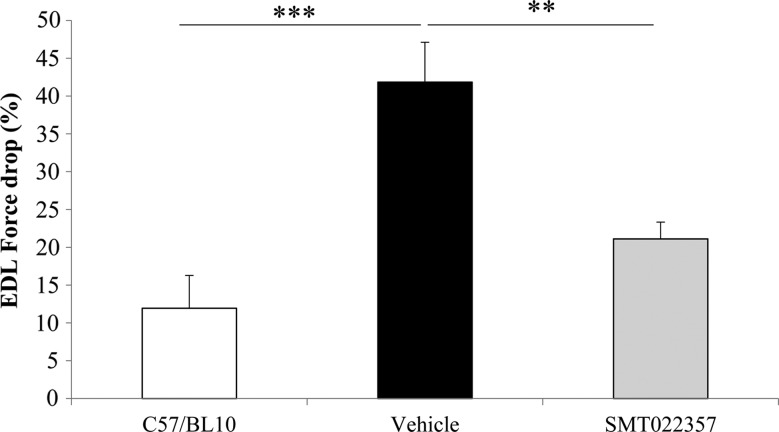
SMT022357 protects the muscle against damage and improves the muscle function. The difference in force produced between the first and fifth stretch is represented as a sensitive indicator of the resistance of the muscle to stretch-induced damage. EDL muscles were stretched at 15% of their fibre length whilst contracting tetanically. Values are mean ± SEM of n = 10 per group; **P < 0.01, ***P < 0.001.